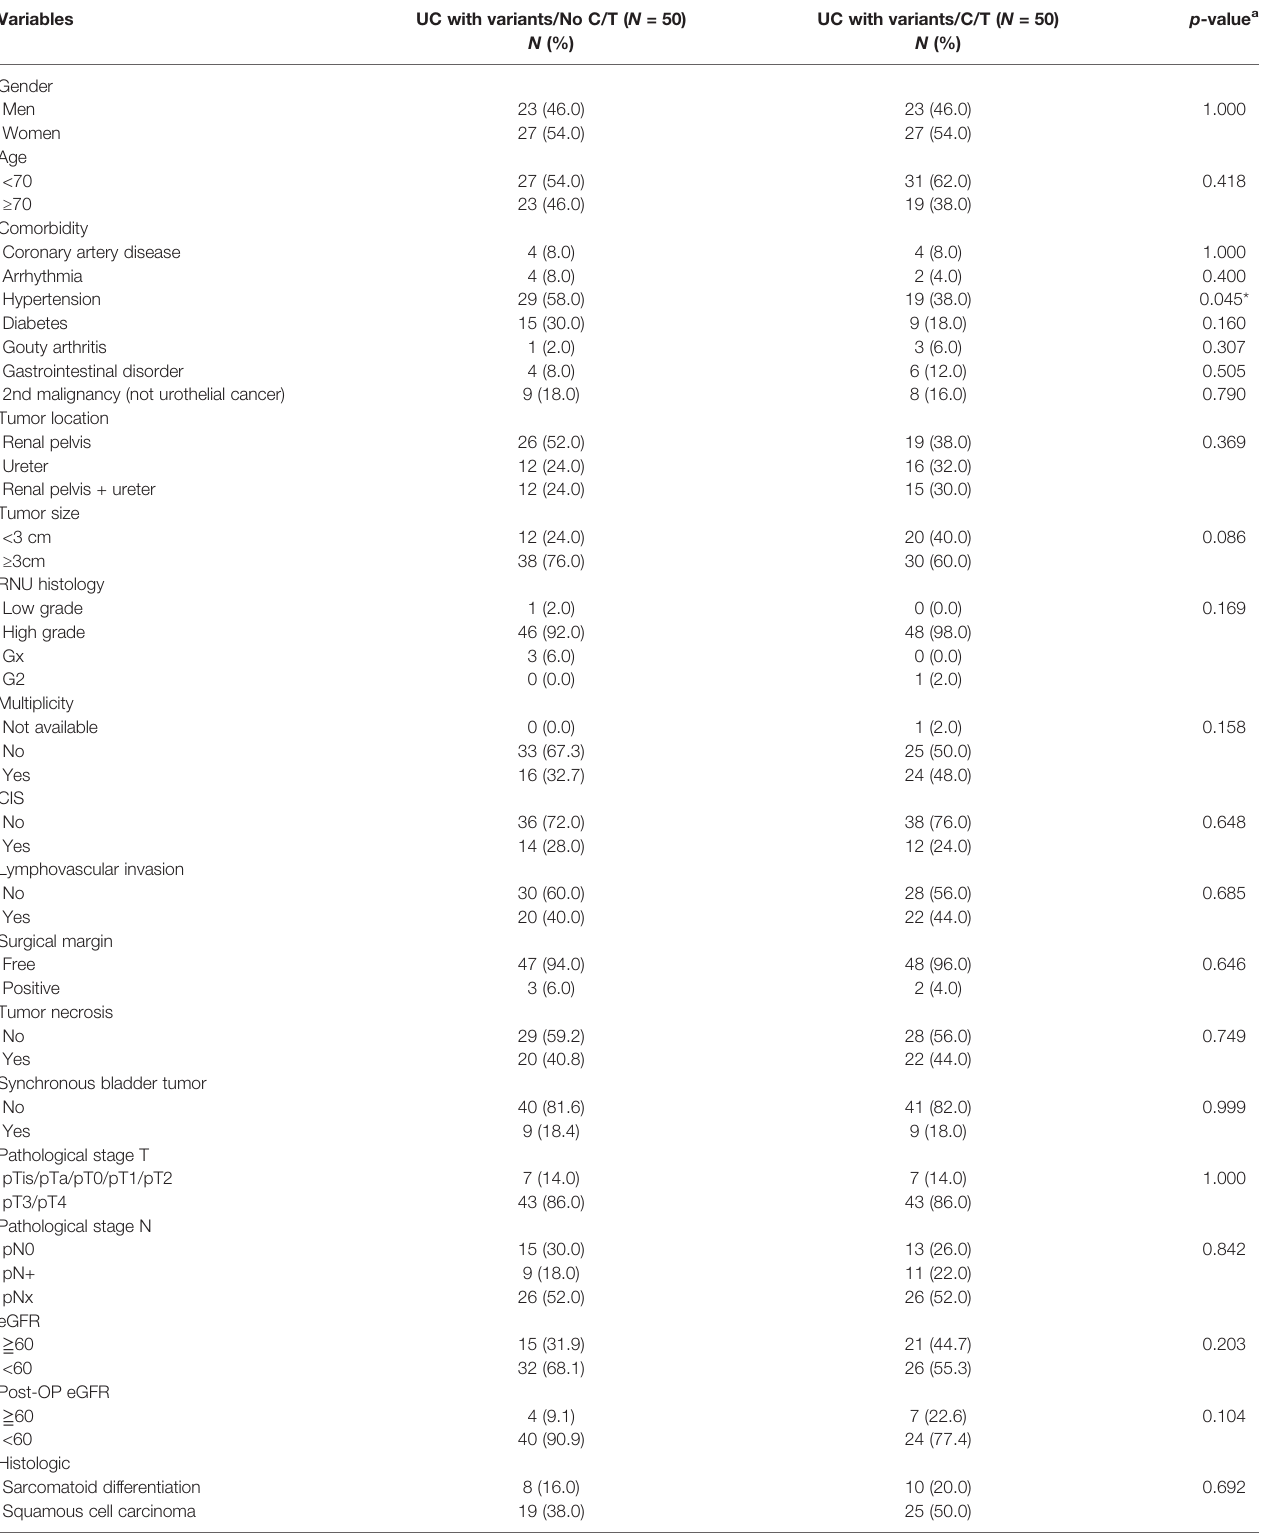
TABLE 2 | Baseline demographic characteristics of patients with variant upper tract urothelial cancer (UTUC) undergoing radical nephroureterectomy (RNU) after